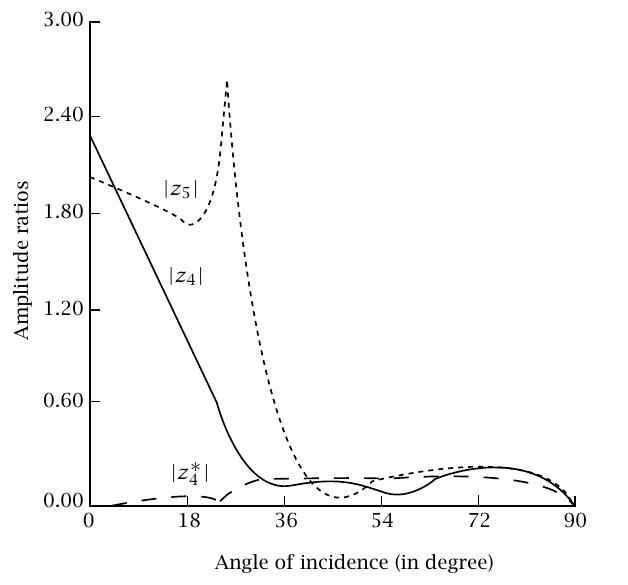
Figure 4.4 . Variation of amplitude ratios with angle of incidence of coupled-wave. incident. In the latter case, the values of the remaining amplitude ratios increase with the increase in the value of viscosity of the